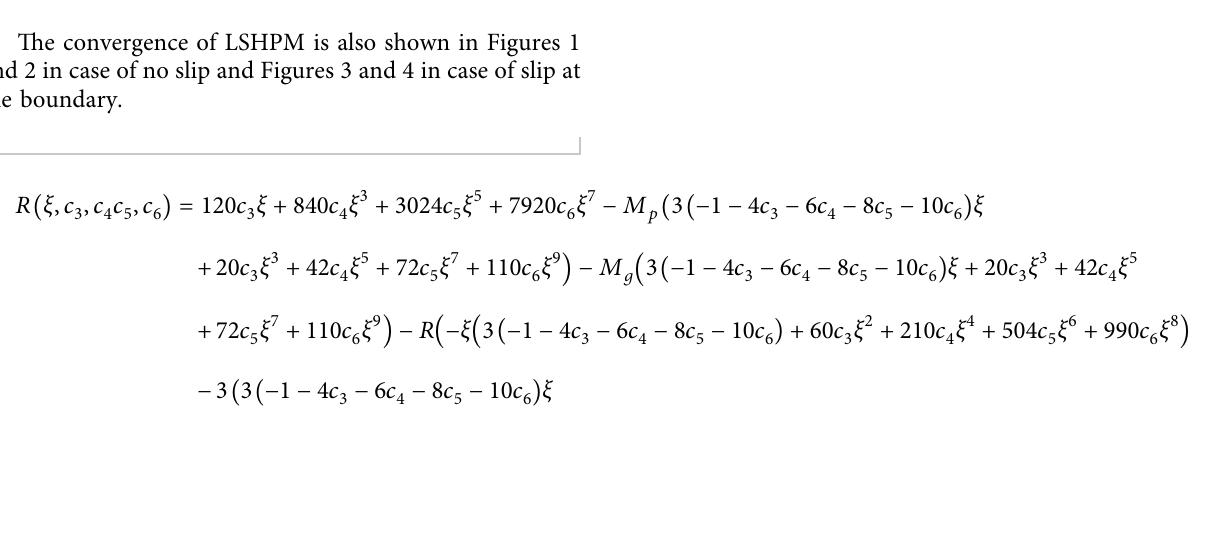
Figure 11: Effect of c on the velocity profile keeping R � 0 . 5, M (b) Axial component of